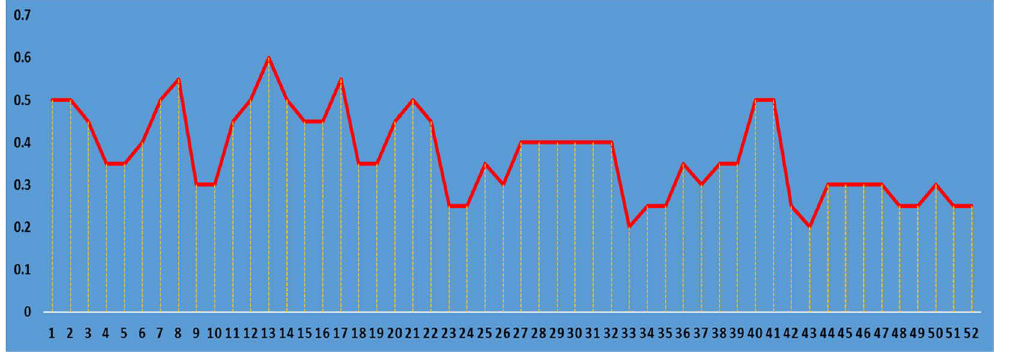
Fig. 2. Multi antibiotic resistance index (MAR index) patterns distribution among 52 E. faecalis